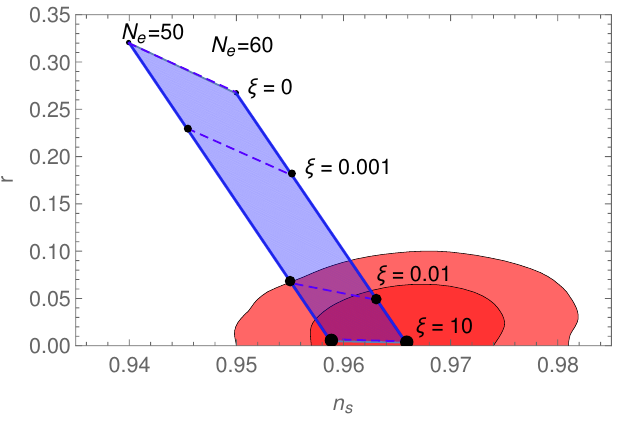
Figure 2 . Observational predictions for an in(cid:13)aton non-minimally coupled to gravity with a quartic potential for 50-60 e-folds of in(cid:13)ation. The red contours correspond to the 68% and 95% C.L. results from